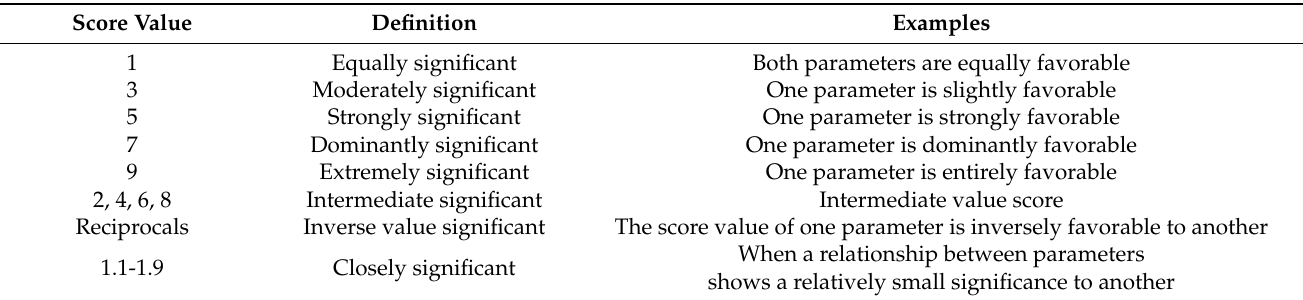
Table 2. Score value for the pairwise comparison after